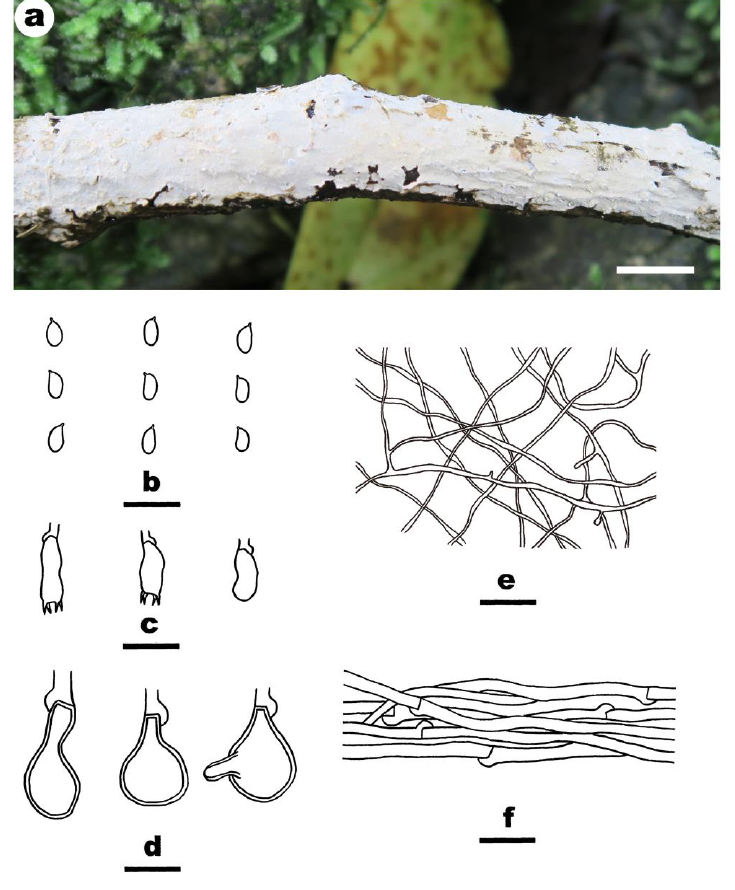
Figure 10. Parvodontia austrosinensis (from the holotype BJFC 024249). Scale bars: ( a ) = 1 cm; ( b – e ) = 10 µm. ( a ). Basidiomes; ( b ). Basidiospores; ( c ). Basidia and a basidiole; ( d ). Gloeocystidia; ( e ). Microbinding hyphae from subhymenium; ( f ). Generative hyphae from subiculum. MycoBank: